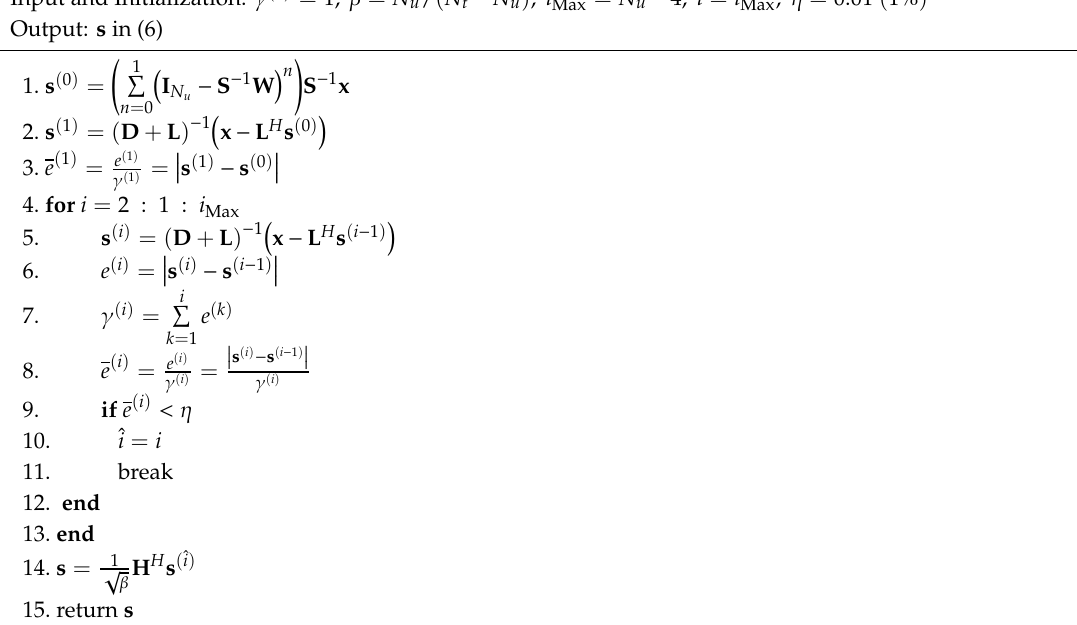
Algorithm 1. An algorithm for GS pre-coding using proposed estimation